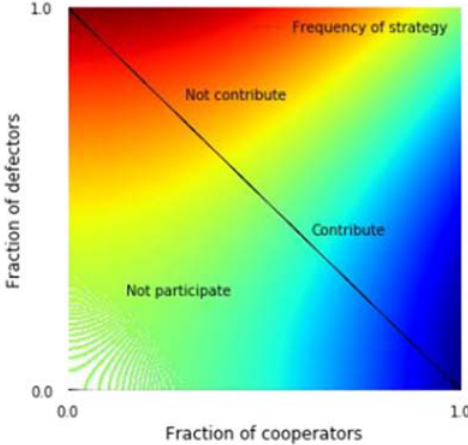
Figure 1. Schematic illustration of model (PGG) with replicator dynamics. Colors indicate prototypes as a proportion of implementation by cooperators (blue = contribute), defectors (red = not contribute), and loners (yellow to green = not participate). The dotted line denotes the relative frequencies, where defectors dominate cooperators, loners dominate defectors, and cooperators dominate loners.